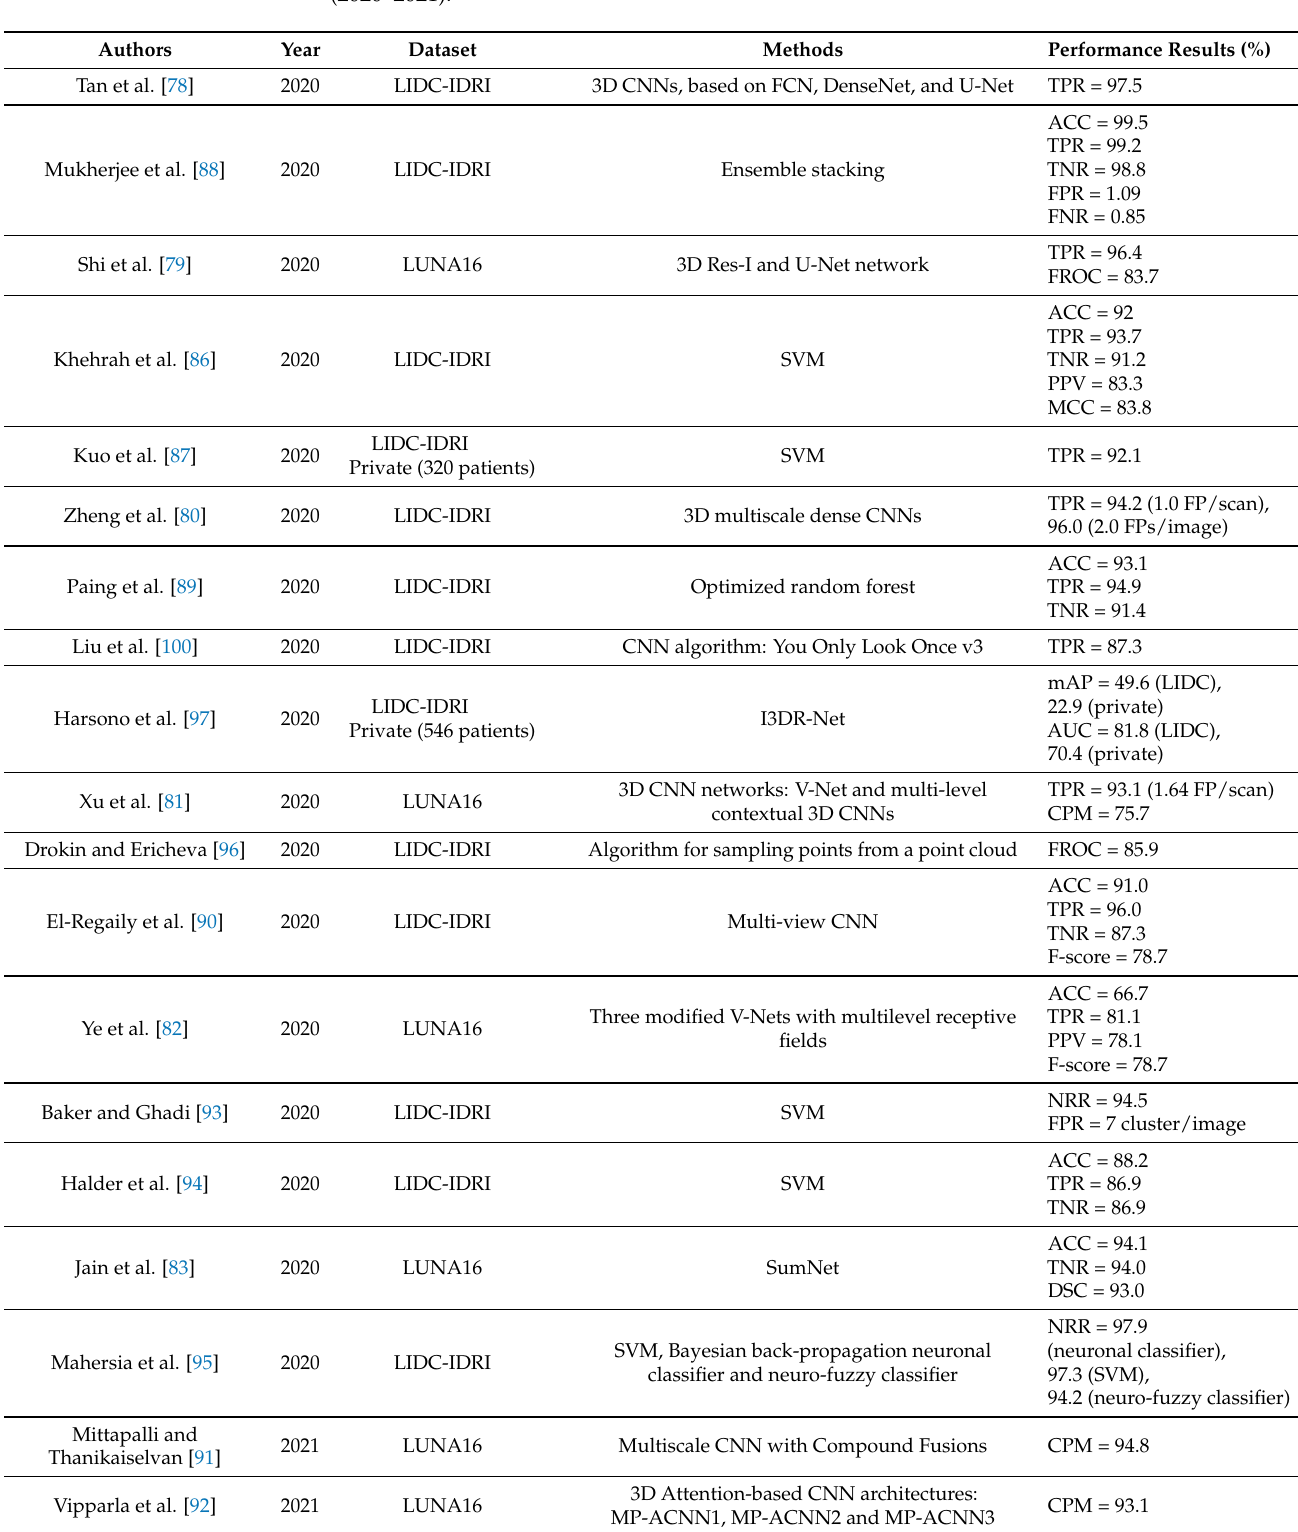
Table 1. Overview of published works regarding nodule detection approaches in lung CT